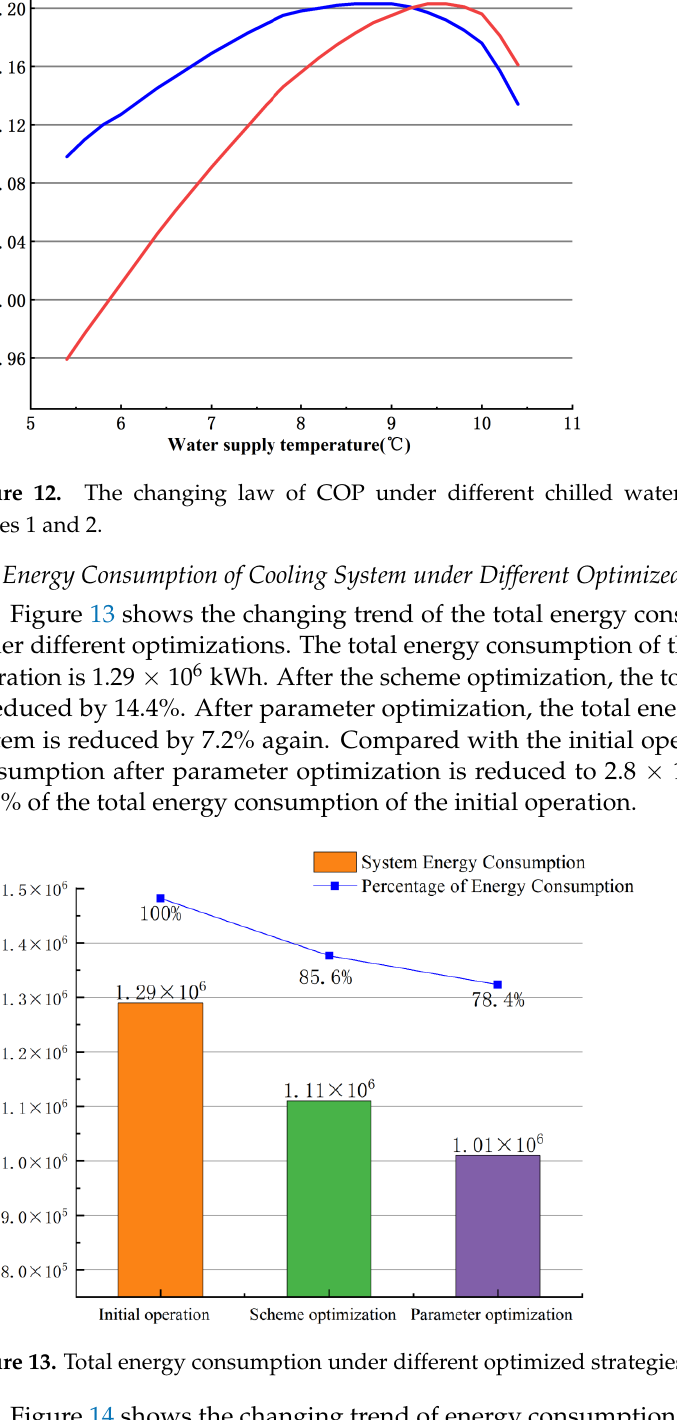
15 of 20 Table 4. Operating parameters and system COP under optimization process. Item